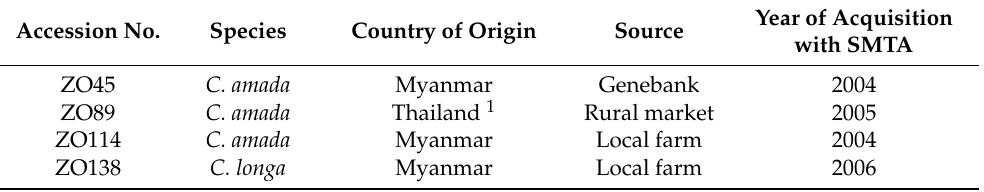
Table 1. List of C. amada and C. longa species with indicated accessions’ number, country of origin, source, and year of acquisition with the Standard Material Transfer Agreement (SMTA). Accession No.